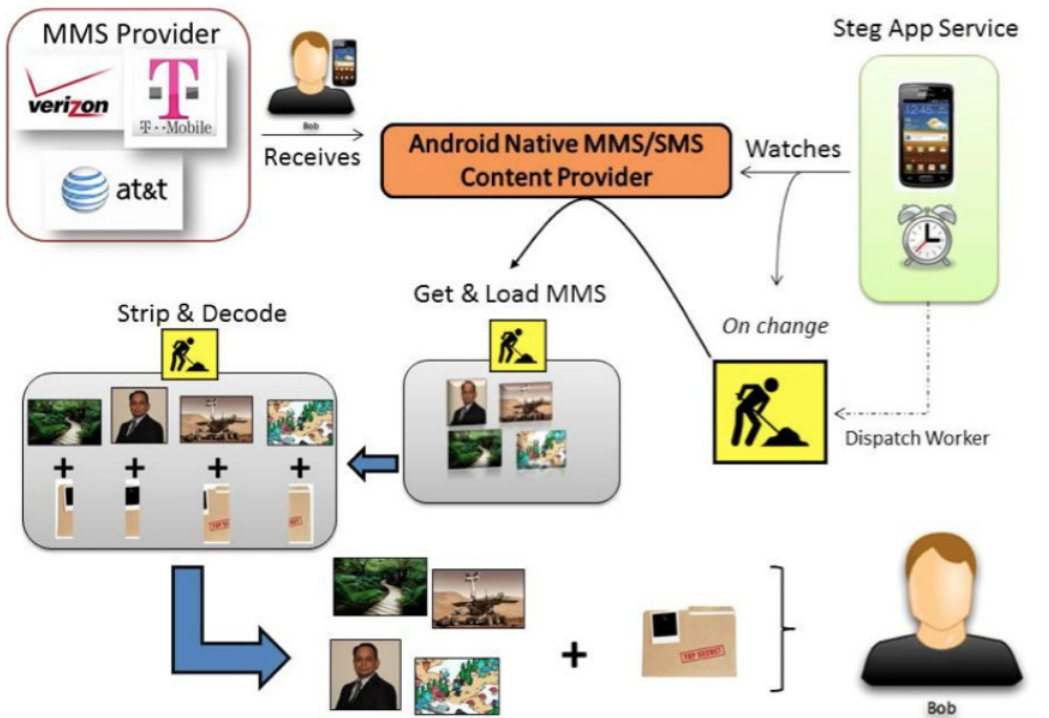
Figure 2: The process of embedding the secret message in a Steganographic MMS message. she wishes to share with